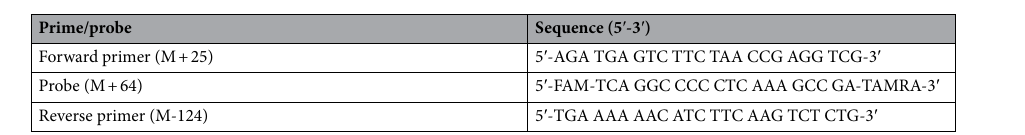
Table 1. PCR primer and hydrolysis probe sequences for the qRT-PCR of the H1N1pdm09 virus. The probe was designed for all-type-A influenza virus M-genes 58 .